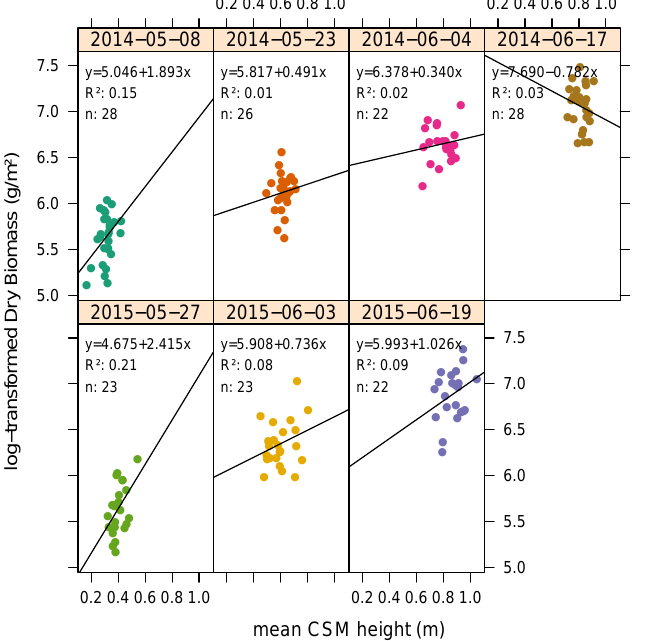
Figure 7. Exponential regression of mean CSM-derived plant height per plot and dry biomass per measurement